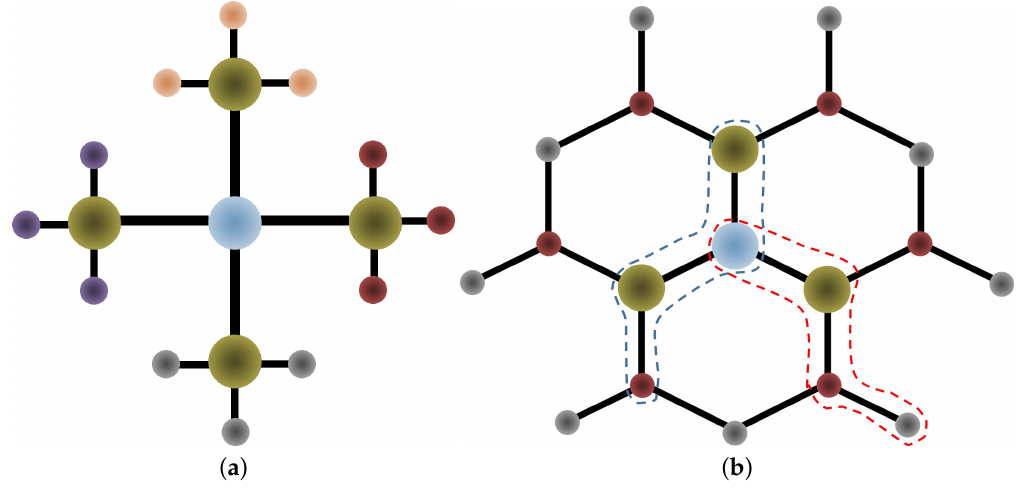
Figure A1. A geometric construction of a molecule with ( a ) n = 4 bonds per atom and ( b ) n = 3 bonds per